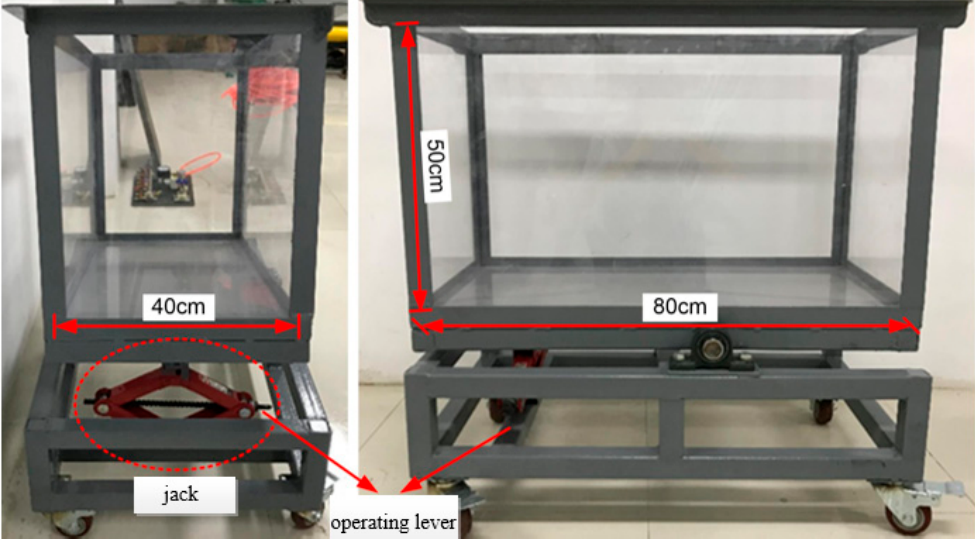
Figure 3. Acrylic model box used in the tests.